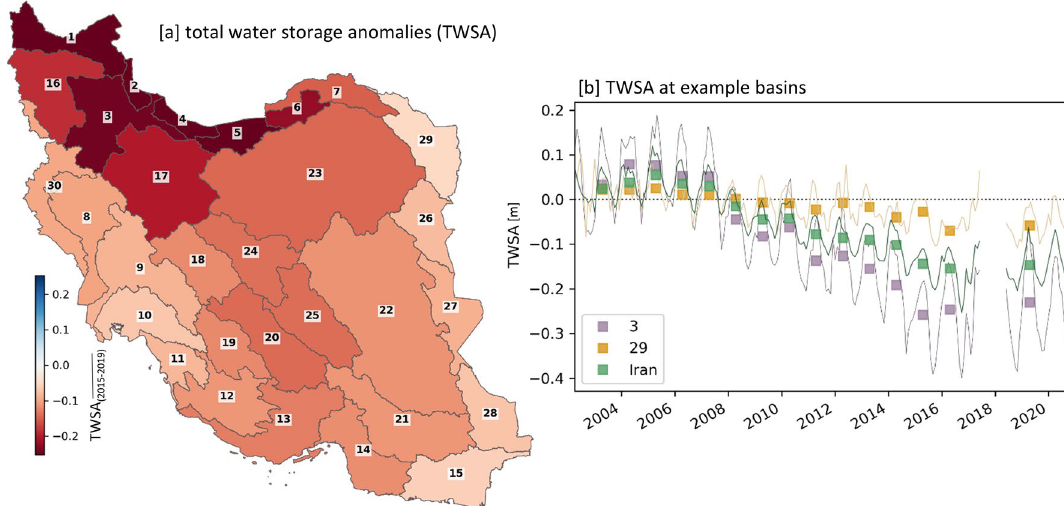
Figure 2. Total water storage anomalies ( TWSA ) observed by GRACE(-FO) (Methods). ( a ): Map showing the average annual TWSA for 2015/2016/2019 per basin as an indicator for the most recent situation. ( b ): TWSA for entire Iran and two selected basins; no. 3 with stronger and no. 29 with weaker decreasing TWS (line: monthly TWSA ; rectangle: annual TWSA , representing an average of monthly data for a water year). Map was created using Python 3.9 (https:// www. python.